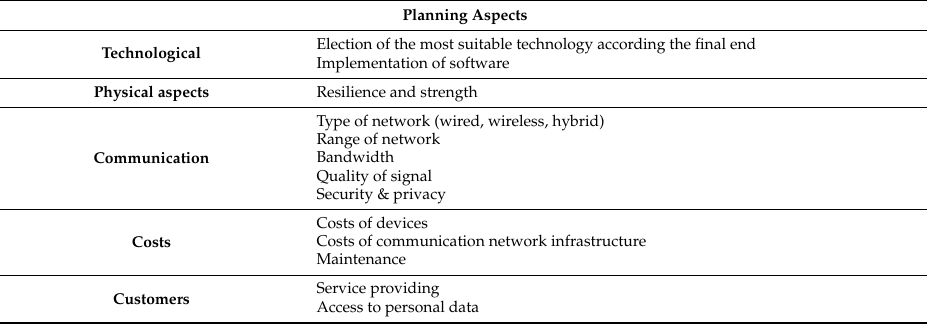
Table 2. Planning considerations for a Smart Metering